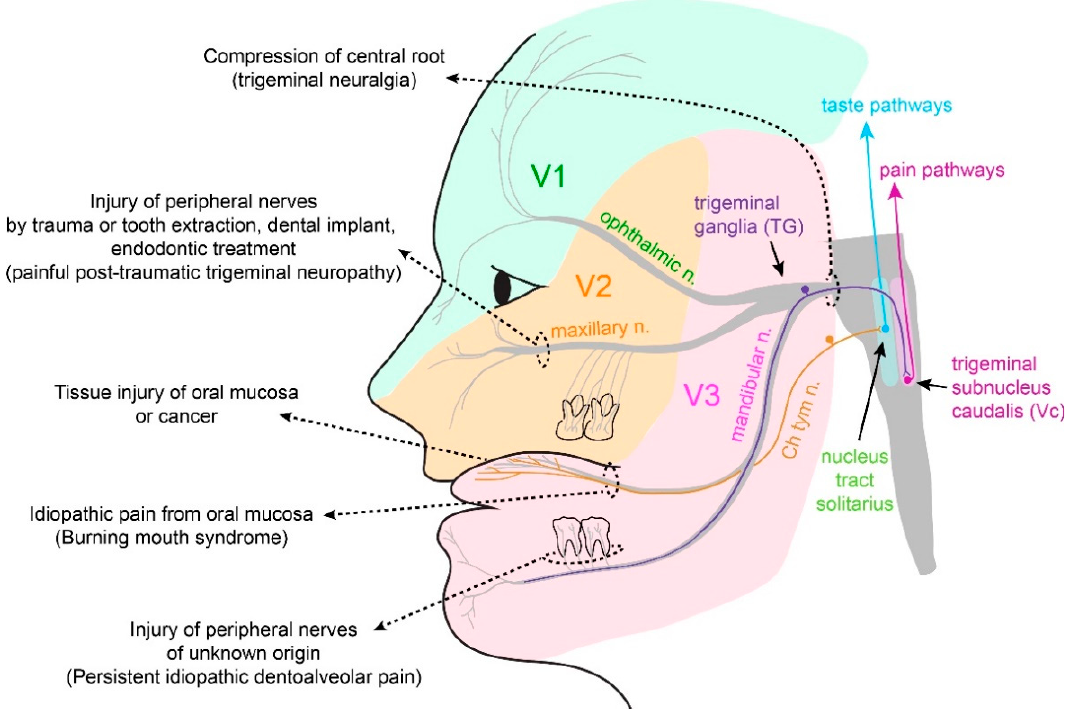
Figure 1. Innervation of the craniofacial sensory nerves, and the sources of persistent orofacial pain from tissue or nerve injuries. The trigeminal nerve is the fifth cranial nerve. The trigeminal ganglia (TG) contain neuronal cell bodies of sensory neurons projecting to the orofacial structures. The first branch (V1) projects to the forehead skin and dura through the ophthalmic nerve. The second branch (V2) projects to the skin, mucosa, and teeth of the upper jaw through the maxillary nerve. The third branch (V3) projects to the skin, mucosa, and teeth of the lower jaw, including the tongue mucosa. The central branches of the trigeminal sensory neurons project to the trigeminal nucleus complex in the brainstem and make synaptic connections with second-order neurons. The pain-sensing nociceptors from the orofacial area are highly connected with the caudal region of the trigeminal nucleus complex (trigeminal subnucleus caudalis; Vc). The Vc neurons relay signals to various ascending pain pathways within the brain. The tongue mucosa is also innervated by gustatory nerves, such as the chorda tympani nerve (Ch tym n), which is a part of the facial nerve (the seventh cranial nerve). Taste signals are transmitted through the chorda tympani nerve, relayed in the nucleus tract solitarius in the brainstem, and transmitted to the central taste pathways. Persistent pain from the orofacial area can be derived from multiple etiologies of injuries to the tissue or nerves. Irradiation or chemotherapy can cause oral mucositis. Oral cancer often causes pain from the oral mucosa. The direct injury of peripheral nerves due to facial trauma or tooth extraction can lead to the development of painful post-traumatic trigeminal neuropathy (PTTN). Trigeminal neuralgia [8] is a distinct entity of chronic pain, derived from compression of the central root of the trigeminal nerve. Some idiopathic chronic orofacial pain, such as burning mouth syndrome (BMS) or persistent idiopathic dentoalveolar pain, are regarded to be of neuropathic